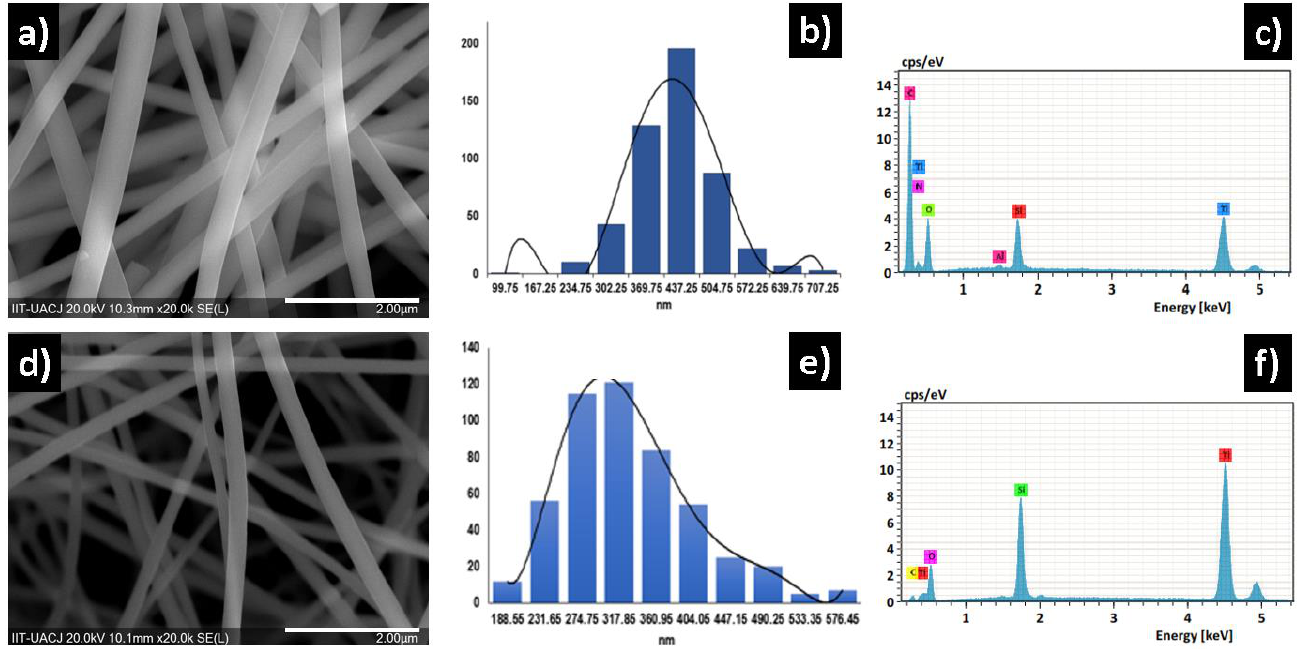
Figure 1. ( a ) SEM image, ( b ) Diameter size distribution and ( c ) EDX spectra of Fibers at 25°C; ( d ) SEM image, ( e ) Diameter size distribution and ( f ) EDX spectra of Fibers treated at 800 °C.